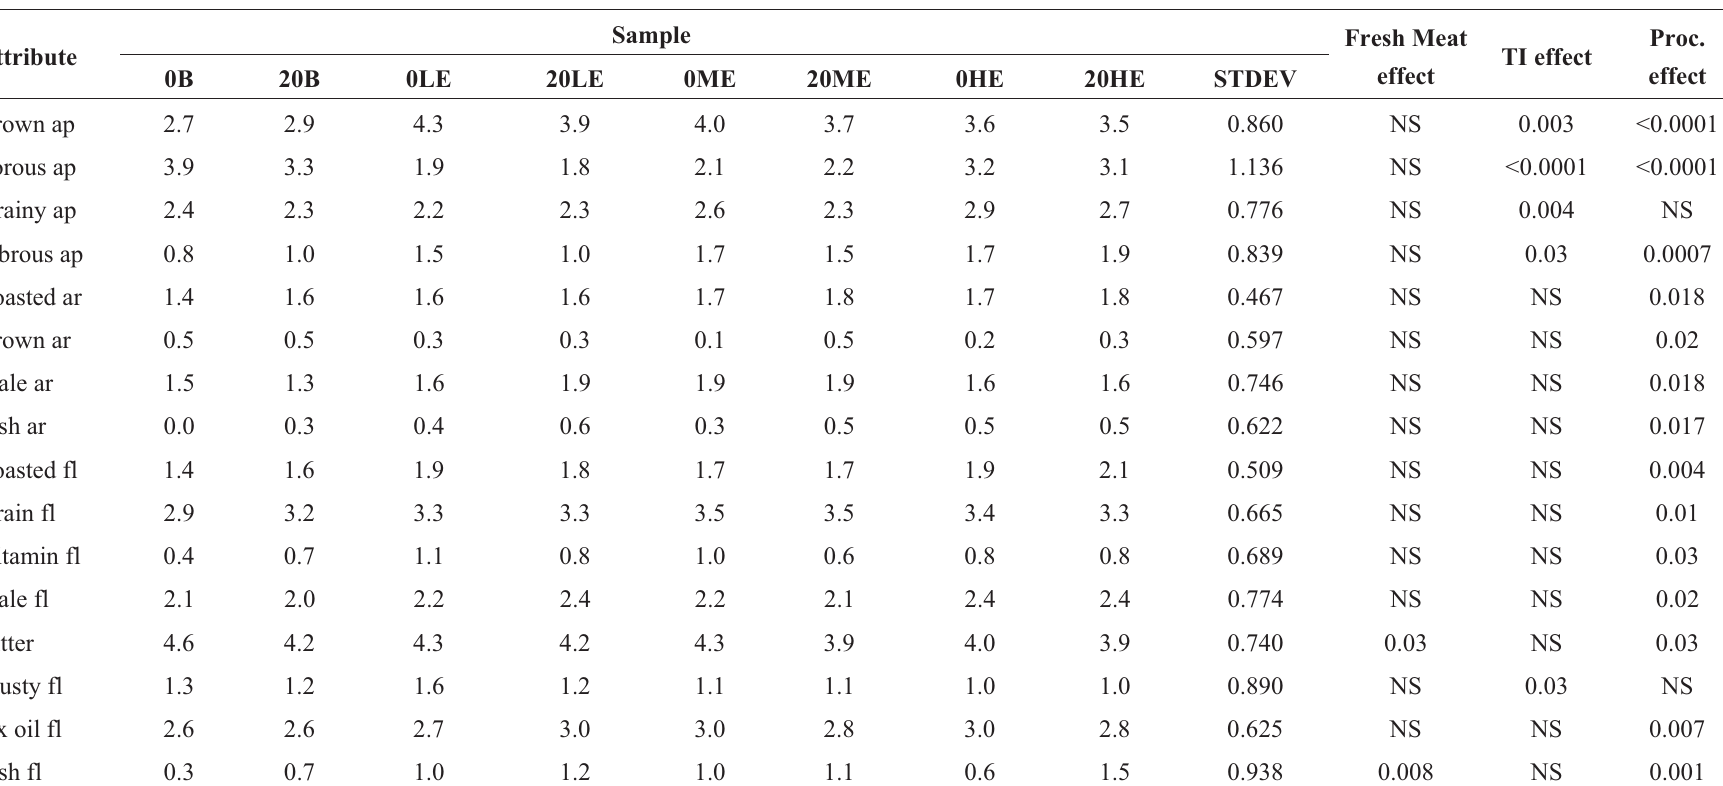
Table 2a. Descriptive sensory analysis attributes (mean values) for pet foods differing in cooking technique, extrusion thermal input, and amount of fresh meat included in the formula reported on an intensity scale of 0 to 15 with 1 being none to 15 extremely